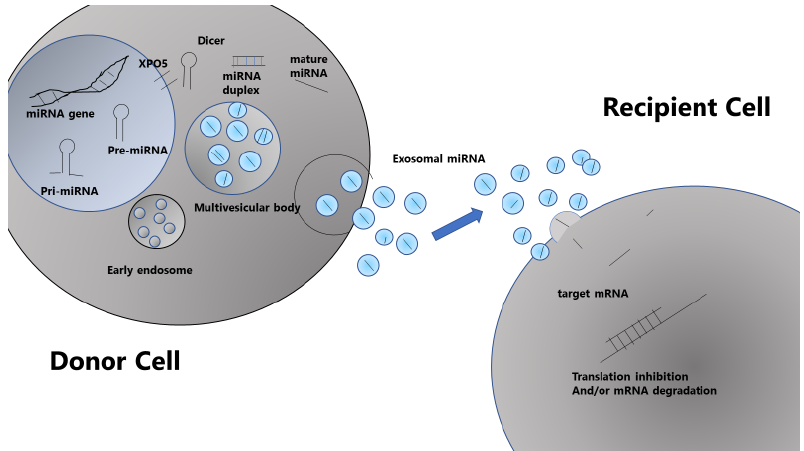
Figure 3. Intercellular communication via exosomes containing miRNAs [89].